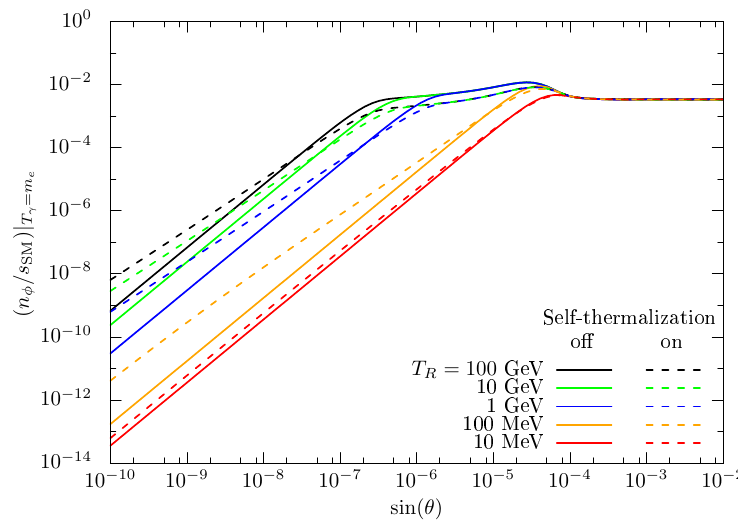
Figure 10. The dark scalar number density at T γ = m e normalized by s SM . We take m φ = 2